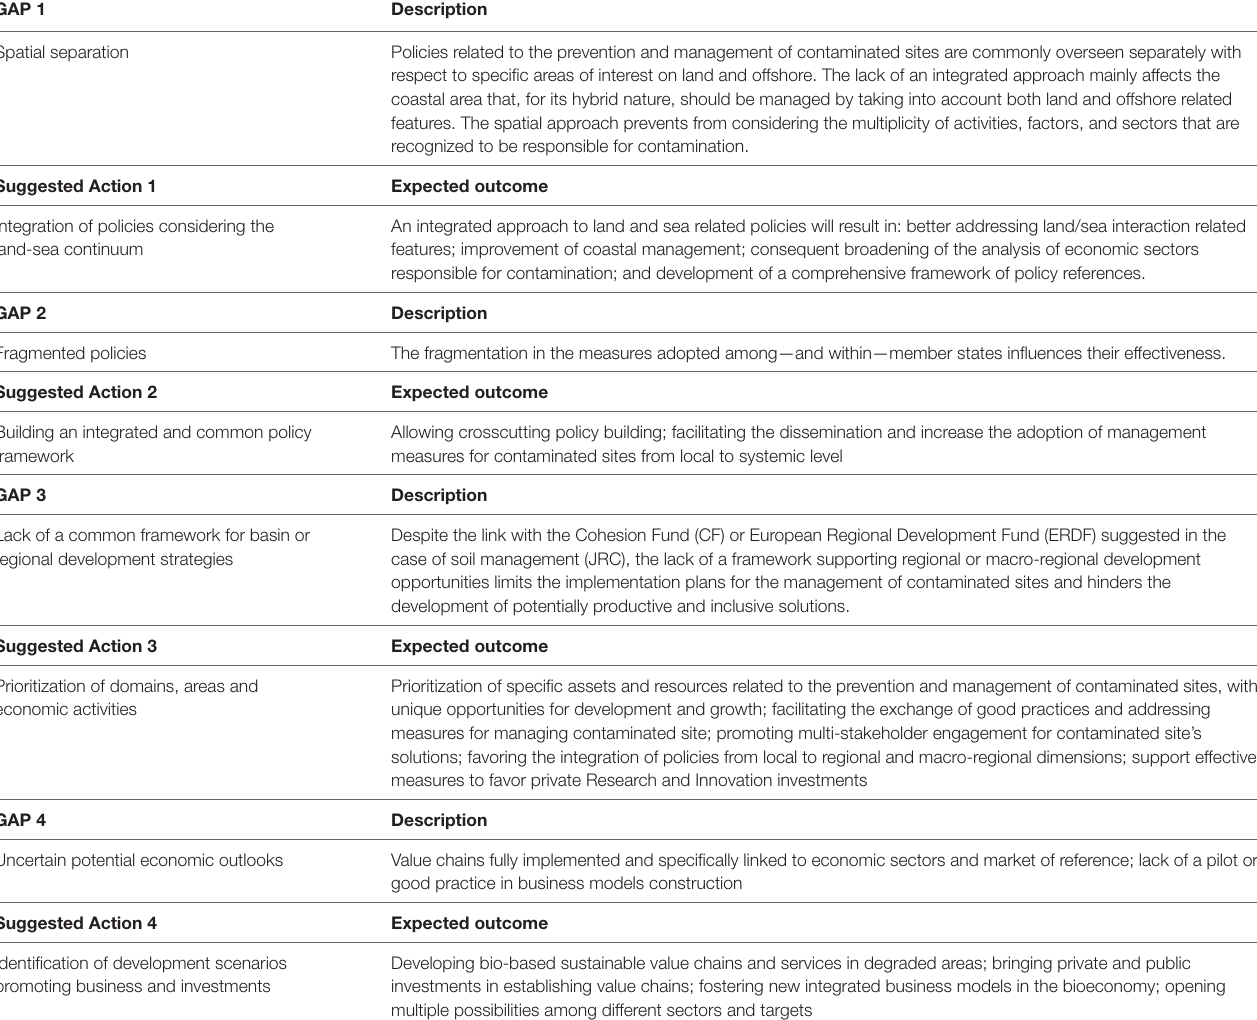
TABLE 1 | Gaps in EU Policy framework and suggested